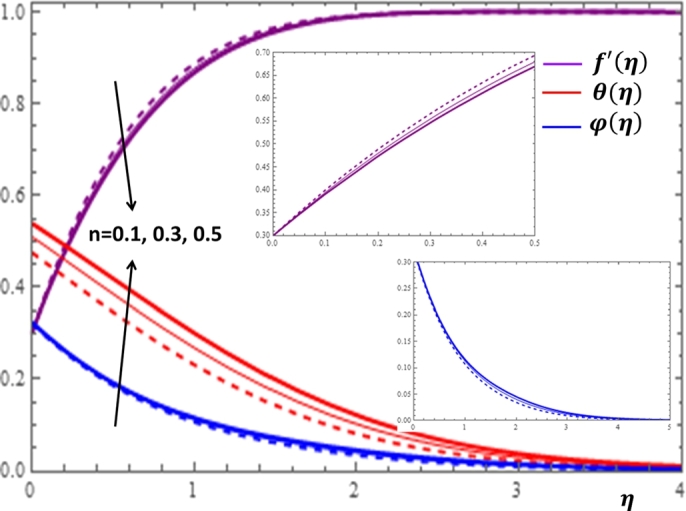
Impacts of the power law index n on f′(η), θ(η) and φ(η).